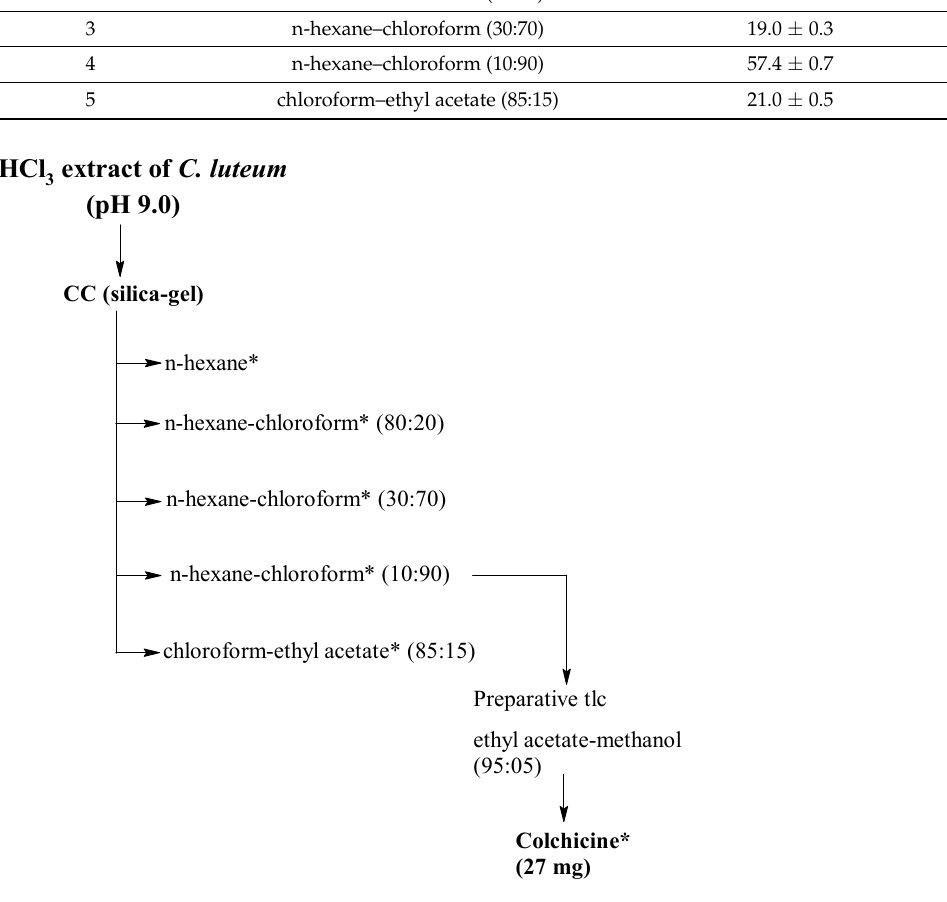
Table 1. Protease inhibition activity of the extracts of C. luteum . S. No Extracts (250 µ g/mL) Protease Inhibition (%Age) 1 ethanol 49.7 ± 1.1 n-hexane chloroform at pH 7.0 24.6 ± 0.7 chloroform at pH 3.0 17.4 ± 0.3 chloroform at pH 9.0 54.1 ± 0.5 The extract of C. luteum at pH 9.0 was loaded on to a glass column coated with silica gel 60. The column was eluted with n-hexane, n-hexane–chloroform, and chloroform–ethyl acetate mixtures in different ratios to achieve 50 mL fractions consecutively. The fractions were subjected to thin-layer chromatography, and similar fractions were combined. The enzyme inhibition assay of each fraction was checked, and their results are presented in Table 2. The fractions collected in n-hexane-chloroform (10:90) were dried and treated to preparative TLC (ethyl acetate–methanol, 95:05), yielding colchicine ( 1 ) as a white solid (27 mg, 7.9 %age yield) as mentioned in Scheme 1 [25]. Rather et al., 2022 also reported colchicine in Colchicum luteum and quantified it using HPLC [26]. Table 2. Protease inhibition activity of the CC fractions of C. luteum (pH 9.0). S. No Fractions (100 µ g/mL) Protease Inhibition (%Age) n-hexane